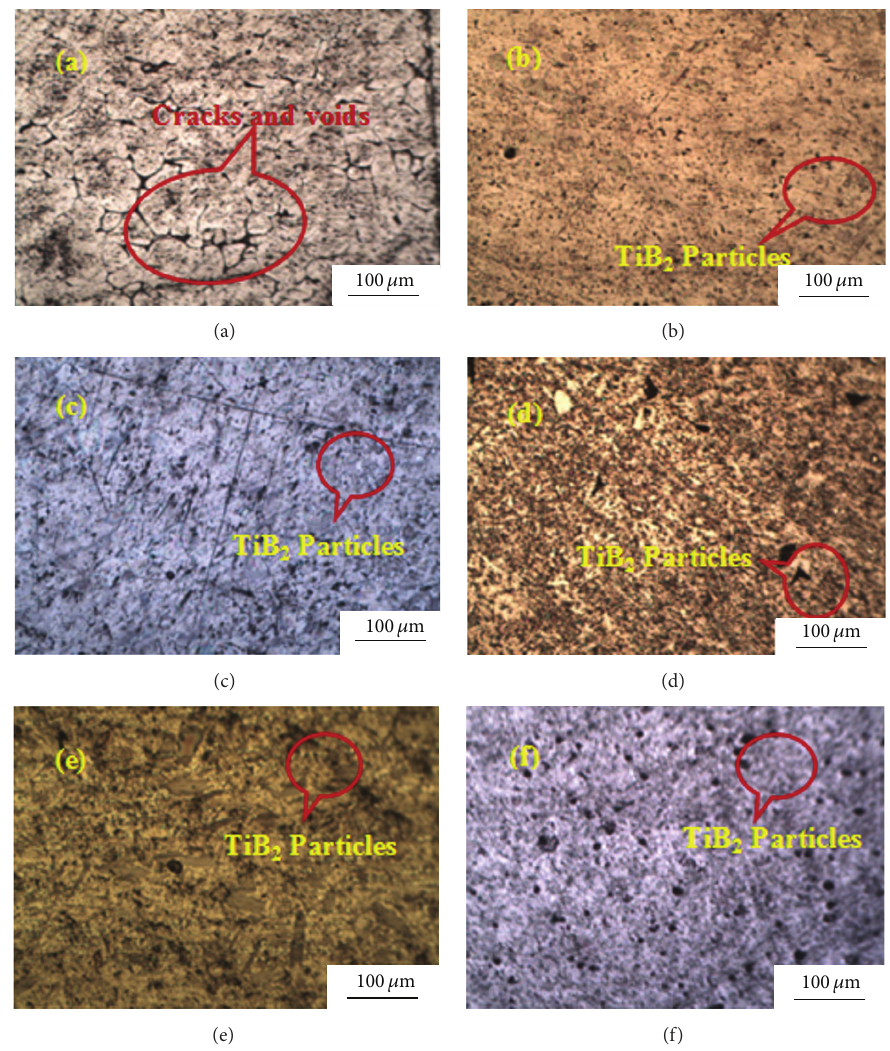
Figure 5: Microstructure images of Al 7075/TiB 2 /Gr hybrid composites: (a) Al 7075/0% wt. TiB 2 /1% Gr, (b) Al 7075/1.5% wt. TiB 2 /1% Gr, (c) Al 7075/3% wt. TiB 2 /1% Gr, (d) Al 7075/4.5% wt. TiB 2 /1% Gr, (e) Al 7075/6% wt. TiB 2 /1% Gr, and (f) Al 7075/3% wt. TiB 2